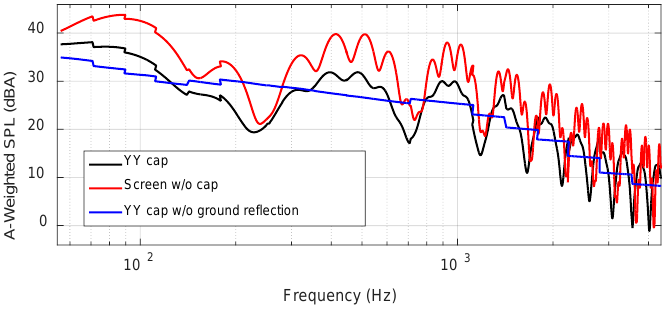
Figure 26. A-weighted sound pressure level (SPL) spectrum in 1 Hz bands in Configuration 2 (Car–Balcony) for the ‘YY’ cap with and without ground reflection. The screen barrier SPL spectrum is shown as a reference.